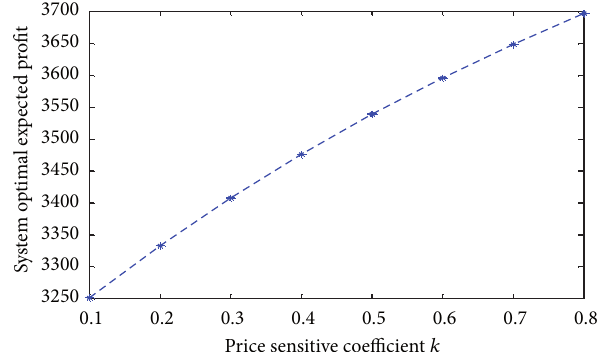
Figure3:Optimalexpectedprofitsfordifferentsensitivecoefficients 𝑘 .